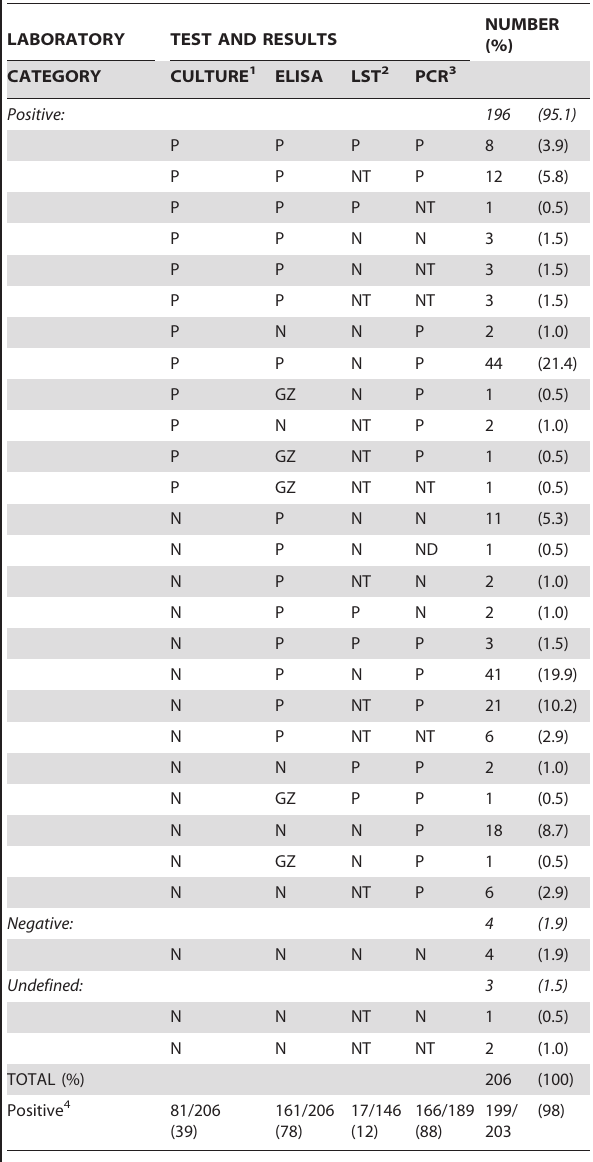
Table 2. Results of laboratory tests for Leishmania infection in dogs collected from the streets of an endemic area of visceral leishmaniasis in